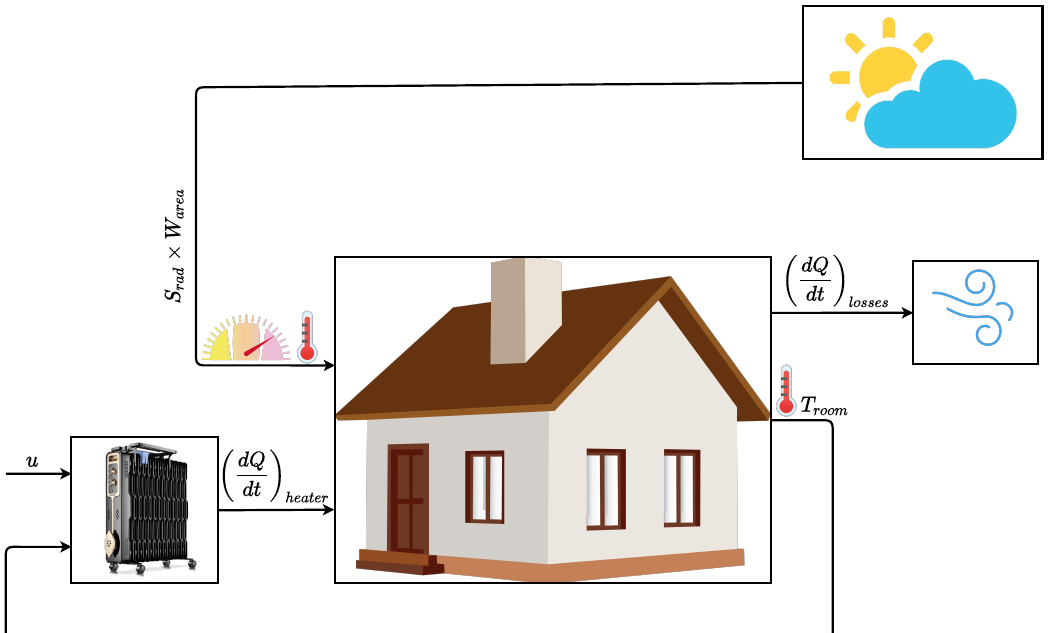
Figure 1. Illustration of the developed indoor environment